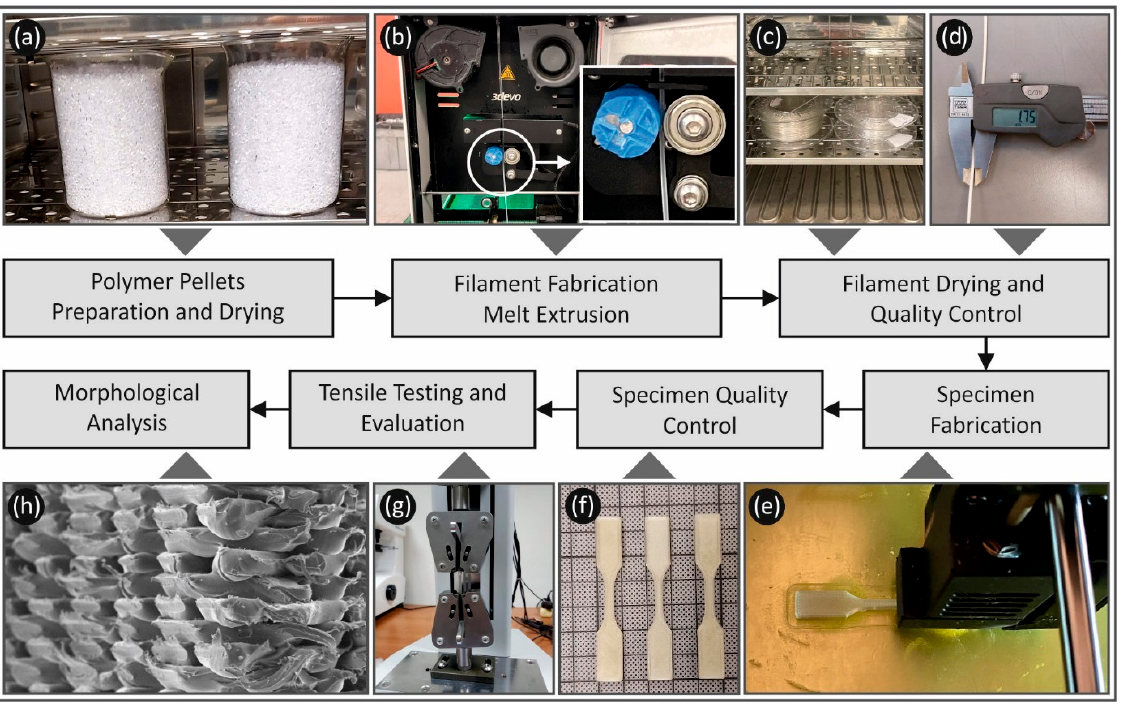
Figure 1. Schematic presentation of the process followed in this work from the specimens preparation to their tests and characterization. ( a ) Pellets drying process, ( b ) filament extrusion process, ( c ) filament drying process, ( d ) filament quality control process, ( e ) specimens 3D printing process, ( f ) tensile test specimens, ( g ) tensile testing of specimens and ( h ) morphological characterization of the tensile test specimens fracture area in SEM.